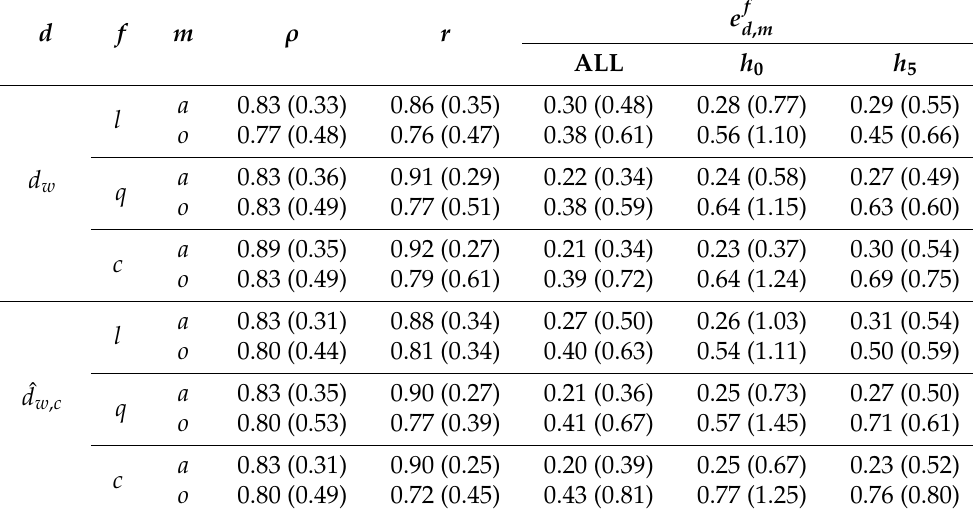
Table 1. Intra-patient ρ , r , e f —either when pooling all patients and blood samples together d , m [ K + ] , expressed as median (ALL) or specifically for h 0 and h 5 —evaluated between ∆ [ K + ] and ˆ ∆ f d , m (interquartile range (IQR)), for each model f ∈ { l , q , c } , marker d ∈ { d w , ˆ d w , c } , and estimation rule m ∈ { a , o }